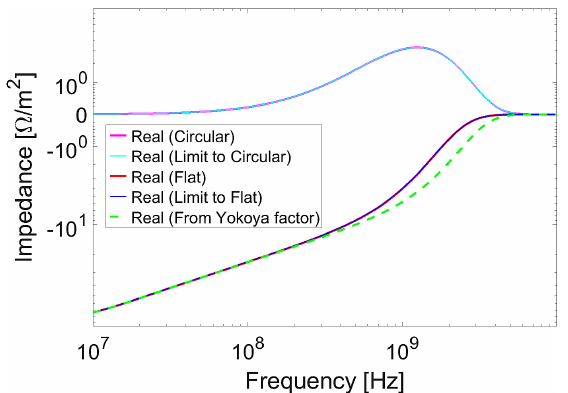
5. Real part of the horizontal detuning impedance per unit of length as given by Eq. (30) in the limits of circular and flat geometries (cyan and blue lines, respectively) for a nonrelativistic case ( β ¼ 0 . 52 ), compared with IW 2 D (magenta and red lines) and with a circular pipe multiplied by the Yokoya factor (green dashed line). The beam pipe, with a radius of 31.3 mm (corresponding to half aperture for the flat beam pipe), has three layers of thicknesses 0.4 mm, 3 mm, infinity and respective conductivities of 7 . 7 × 10 5 S = m, 1 × 10 4 S = m, and zero (vac- uum